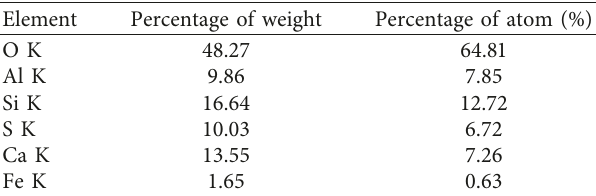
Table 3: EDS of region